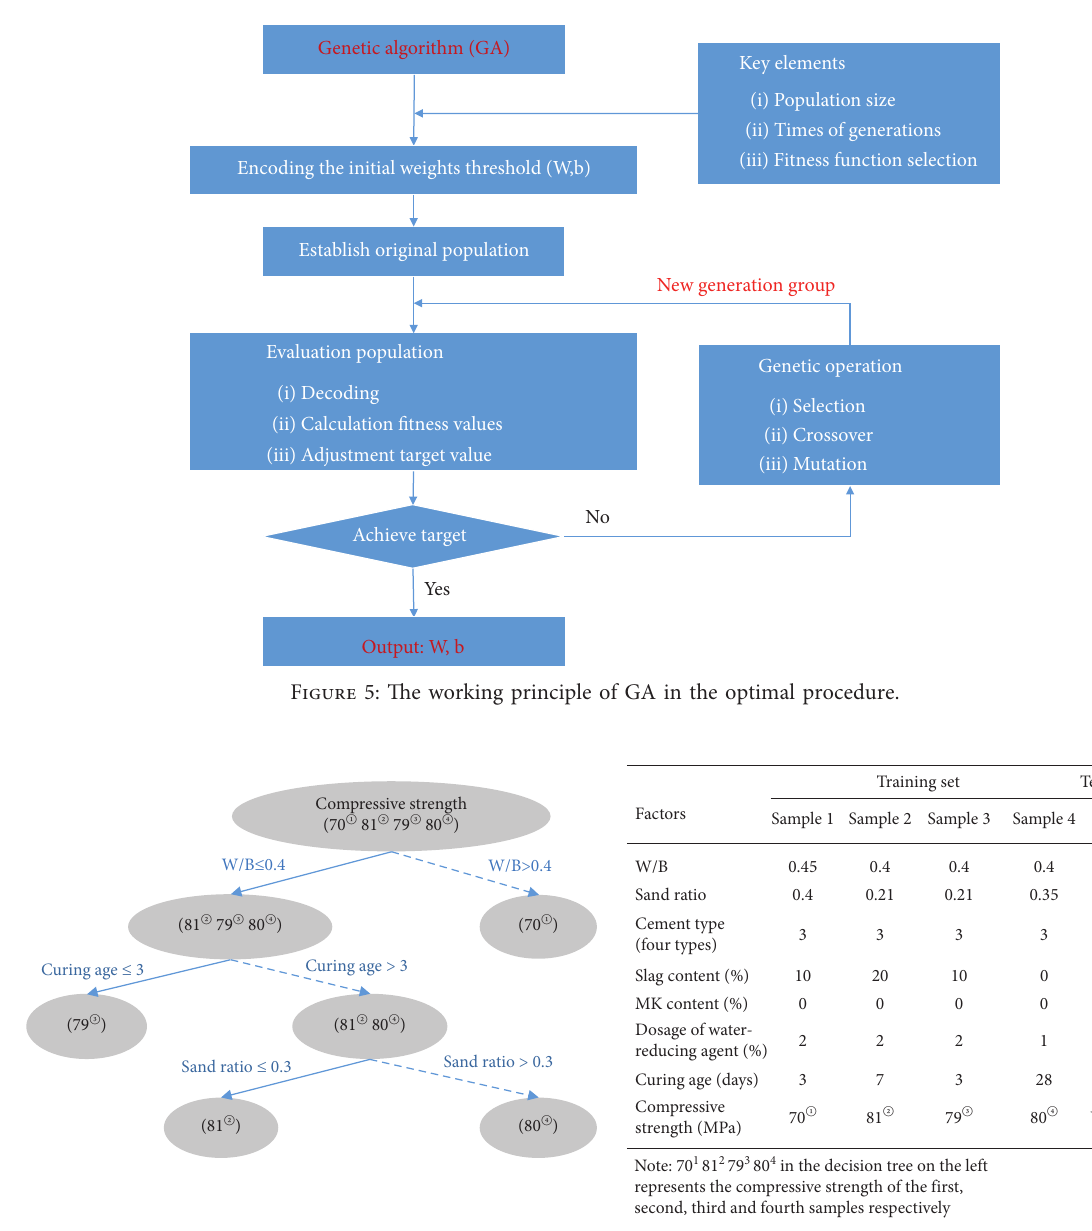
Figure 6: The training process of a traditional decision